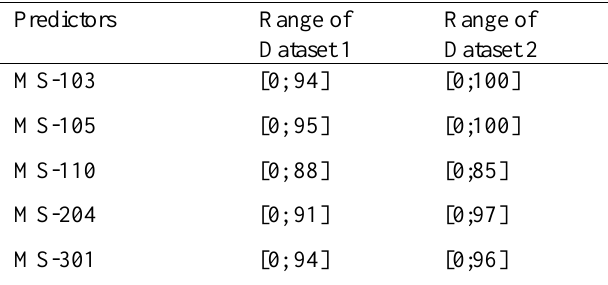
Comparison of datasets for Mathematical Courses Predictors